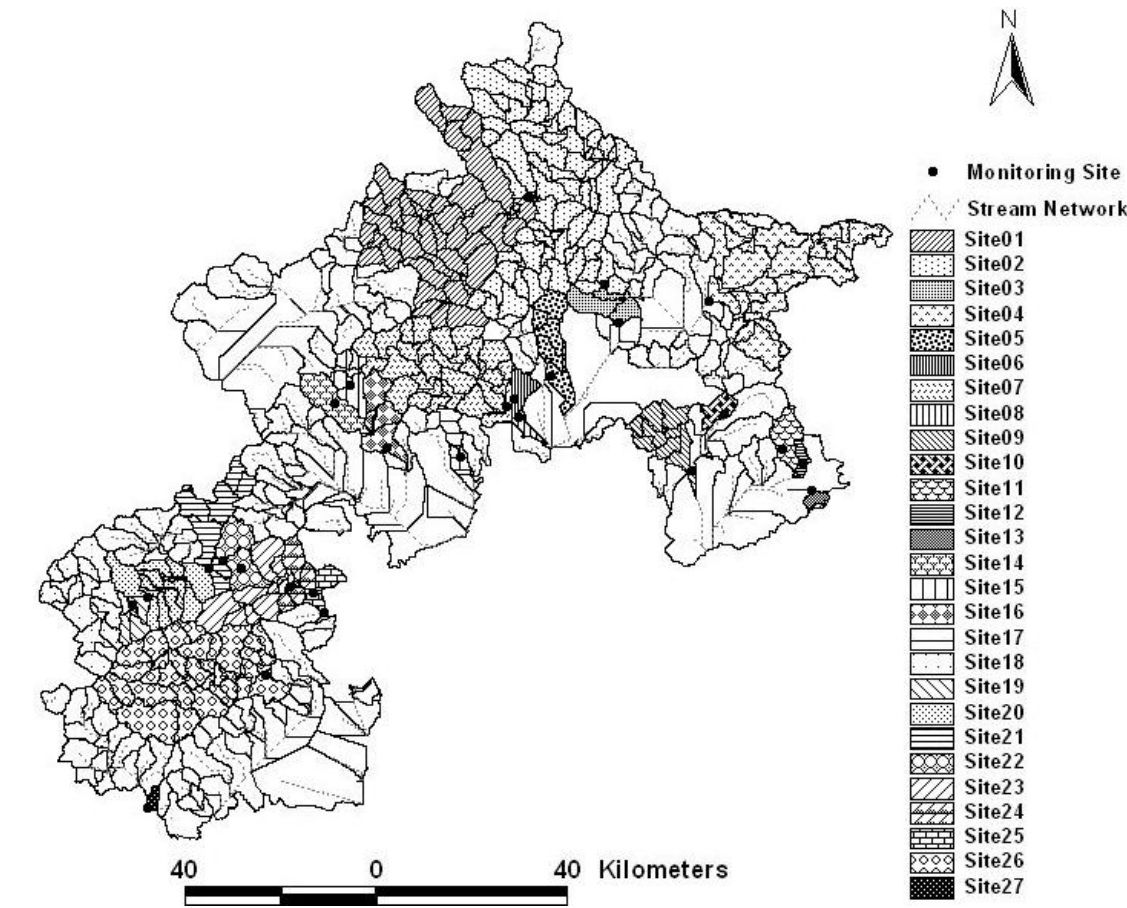
Figure 4. The whole watersheds for the 27 monitoring